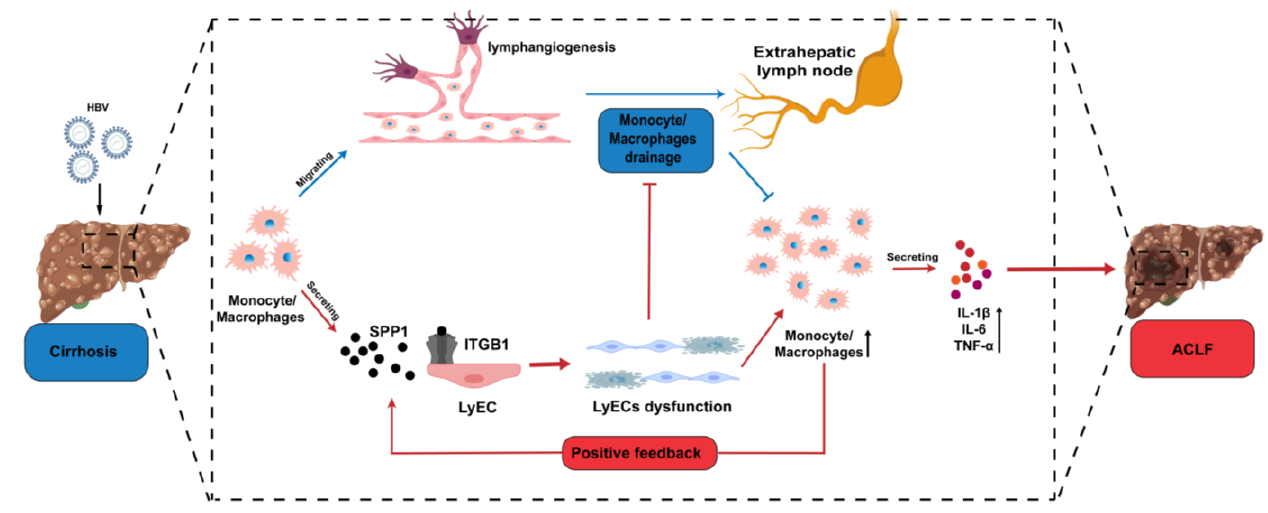
Figure 6. The diagram of the present study.